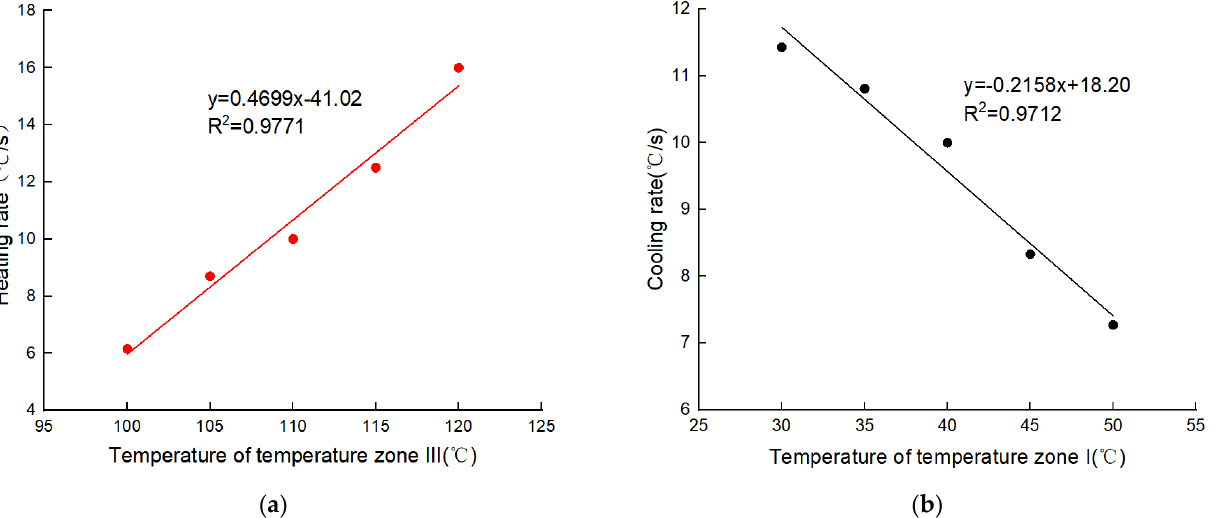
Figure 9. The ramp rate of solution at different temperatures (different temperature differences) in TZ III and TZ I: ( a ) Linear regression model of heating ramp rate and temperature at different temperatures in TZ III; ( b ) Linear regression model of cooling ramp rate and temperature at different temperatures in TZ I.